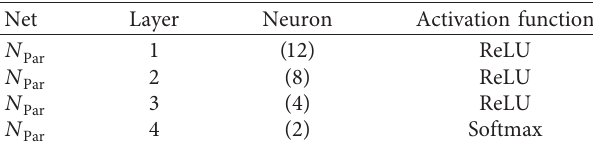
Figure 6: The network architecture based on LeNet-5 with two convolutional layers, two pooling layers, and two fully connected layers in total. Table 1: Network details of N . Par